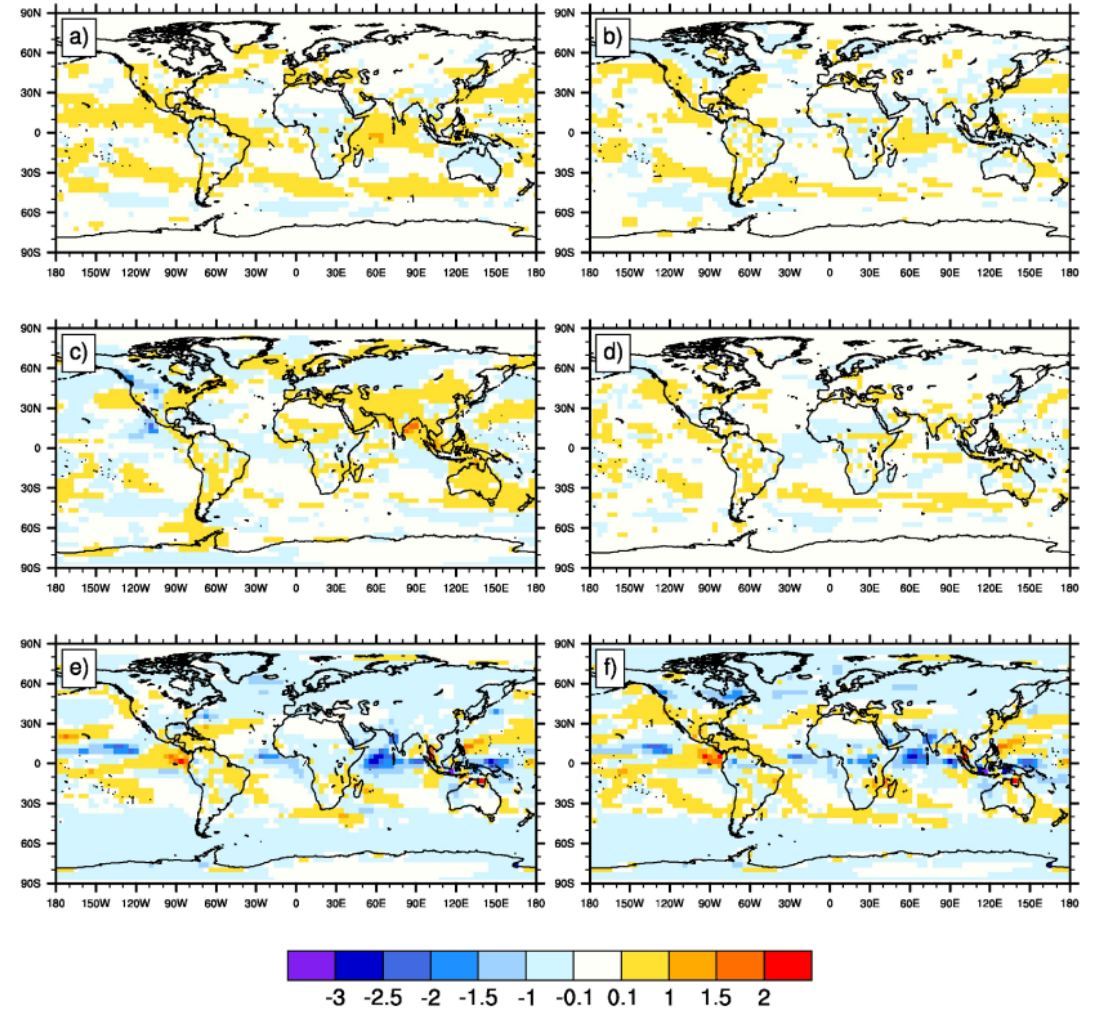
Fig. 5. Annual mean difference of total precipitation (mmday − 1 ) of (a) GHG, (b) albedo, (c) topography, (d) orbital, (e) SST, and (f) LGM-combined experiments from the control run.